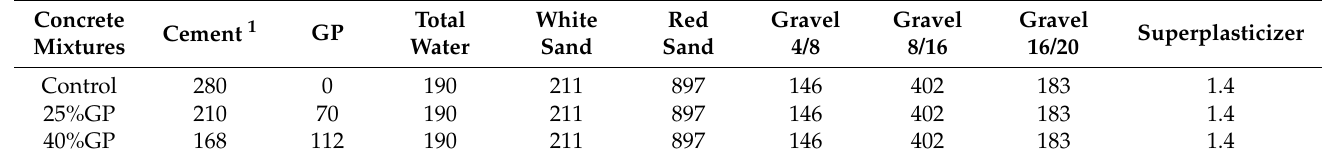
Table 2. Concrete mixtures replacing 25% or 40% cement with GP (kg/m 3 ).